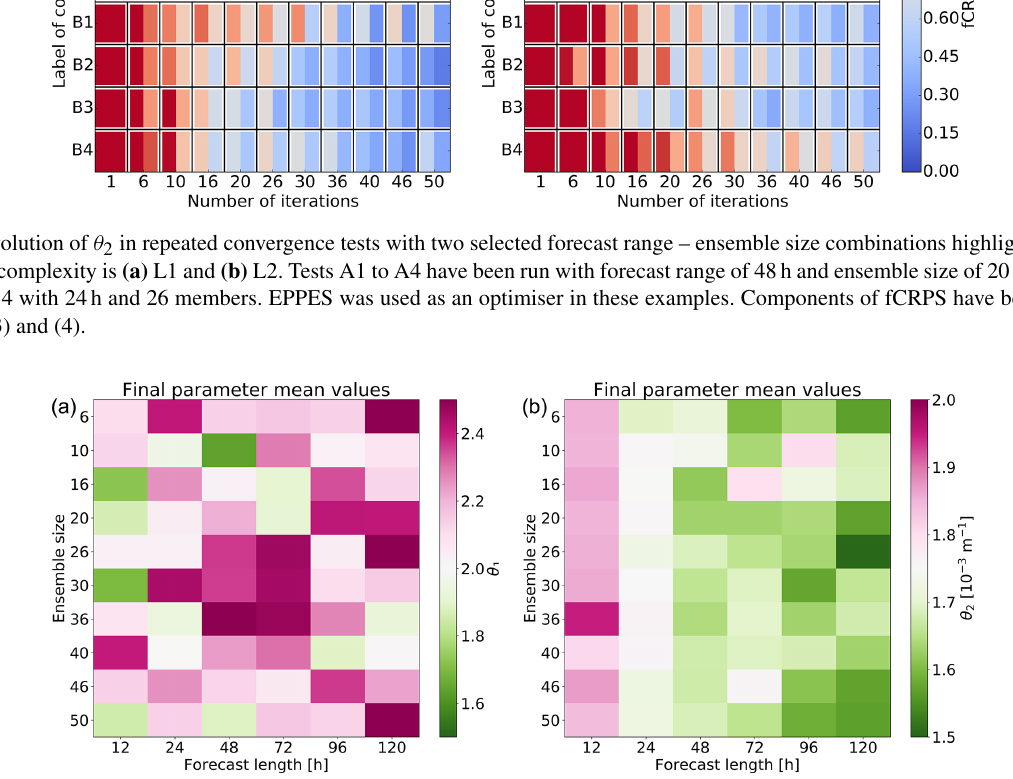
Figure 6. Mean values of the parameter distributions proposed by EPPES at the end of the convergence tests: (a) θ 1 and (b) θ 2 . Purple (green) colour means that the final mean values are larger (smaller) than the default